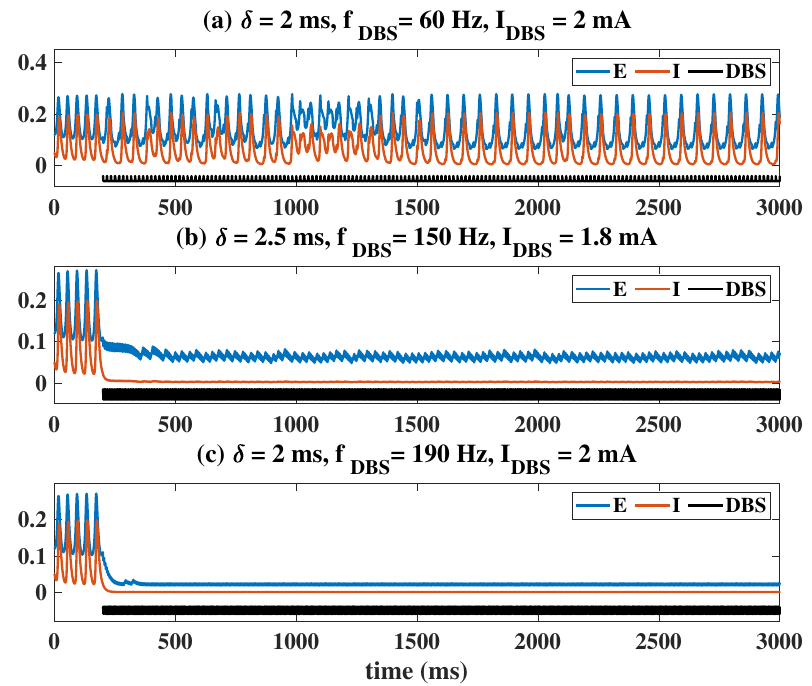
Figure 4. Control effects of DBS under different parameter settings. The control effect shown in ( c ) is better than that of ( a , b